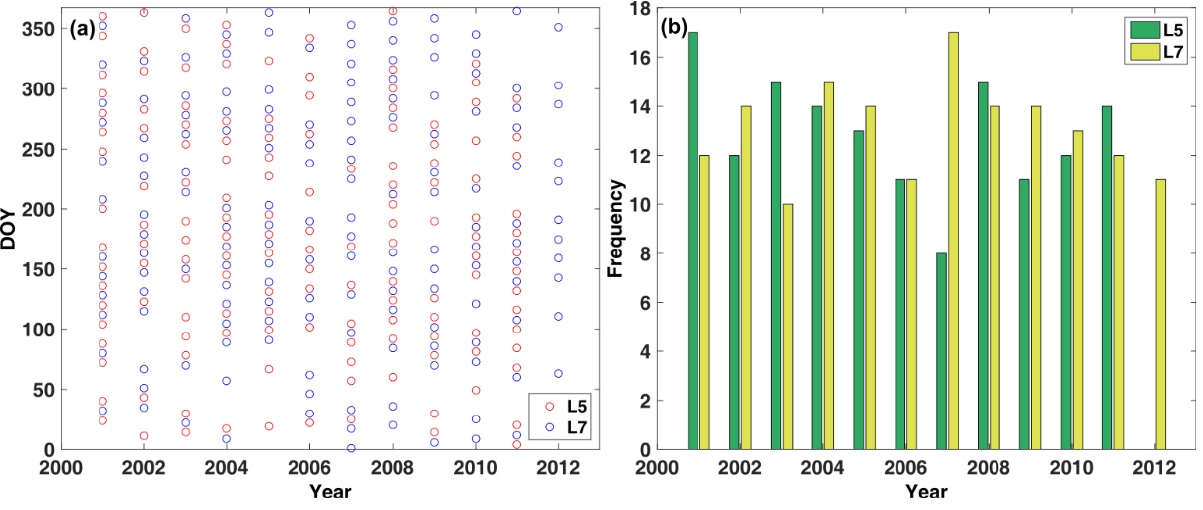
Figure 2. Distribution of the Landsat data used in the study. ( a ) day of year (DOY), ( b ) frequency from the period 2001 to 2012. L5 denotes Landsat TM data, L7 denotes Landsat ETM+